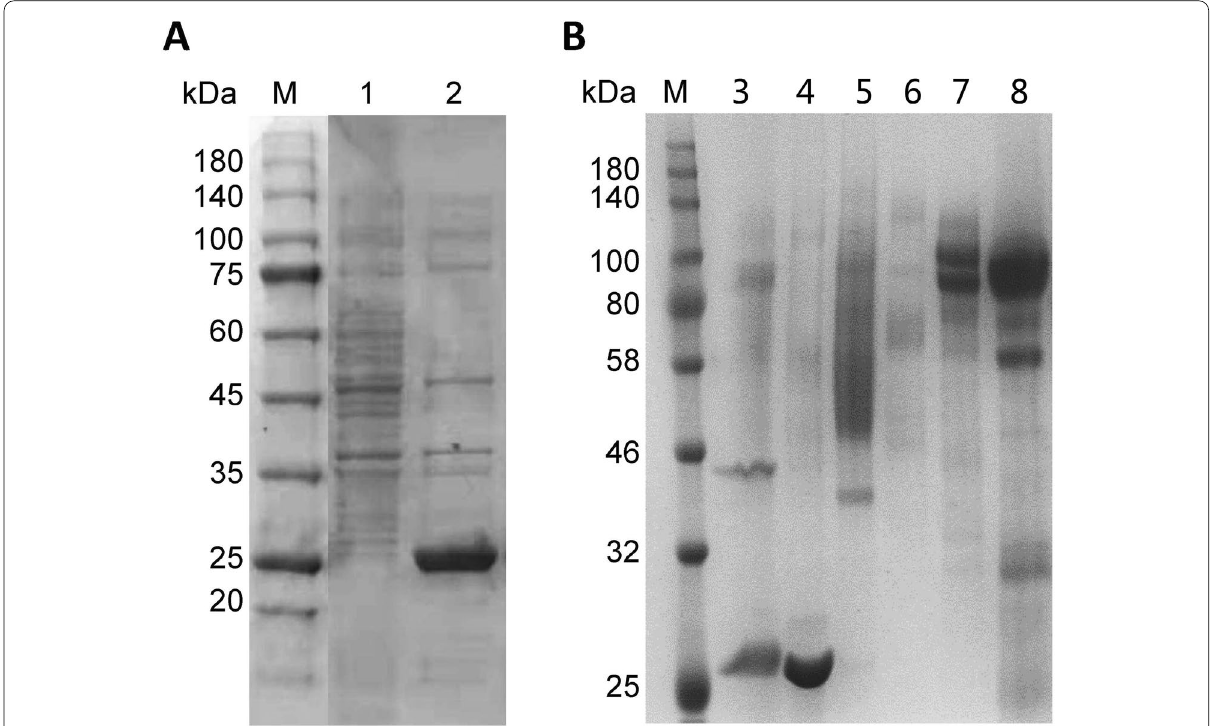
Fig. 1 Constitutive expression and purification. A Constitutive expression in GPY medium. Lane M: protein marker; lane 1: concentrated supernatant of original strain; lane 2: concentrated supernatant of recombinant. B Purification of An EGL by anion exchange chromatography. Lane M: protein marker; lane 3: ultrafiltrate; lane 4: wash with 20 mM pH 7.0 sodium phosphate buffer; lanes 5 to 8: elution with 0.1, 0.2, 0.3, 0.5 M